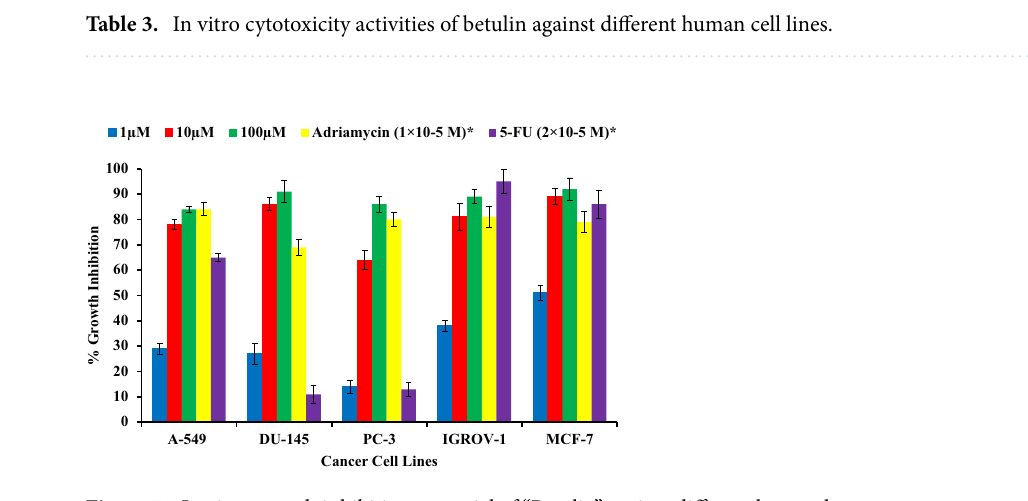
Figure 7. In vitro growth inhibition potential of “Betulin” against different human lung, prostate, ovary and breast cancer cell